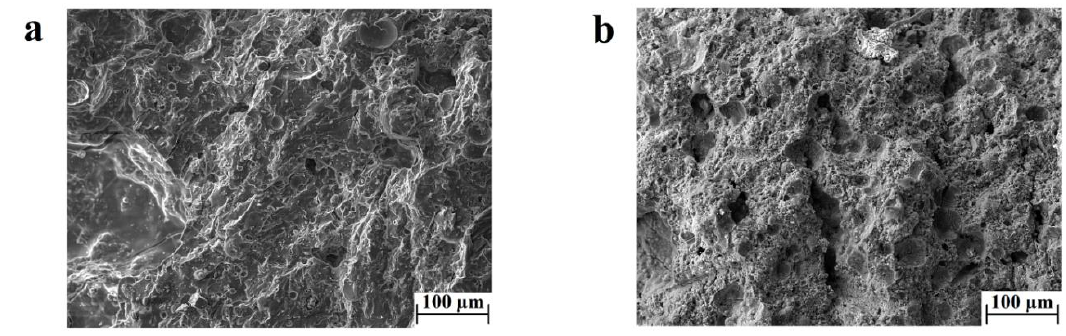
Figure 2. SEM images of ( a ) the ‘Mix-2’ sample sealed according to method 1 and ( b ) the ‘Mix-2’ sample sealed according to method 2.